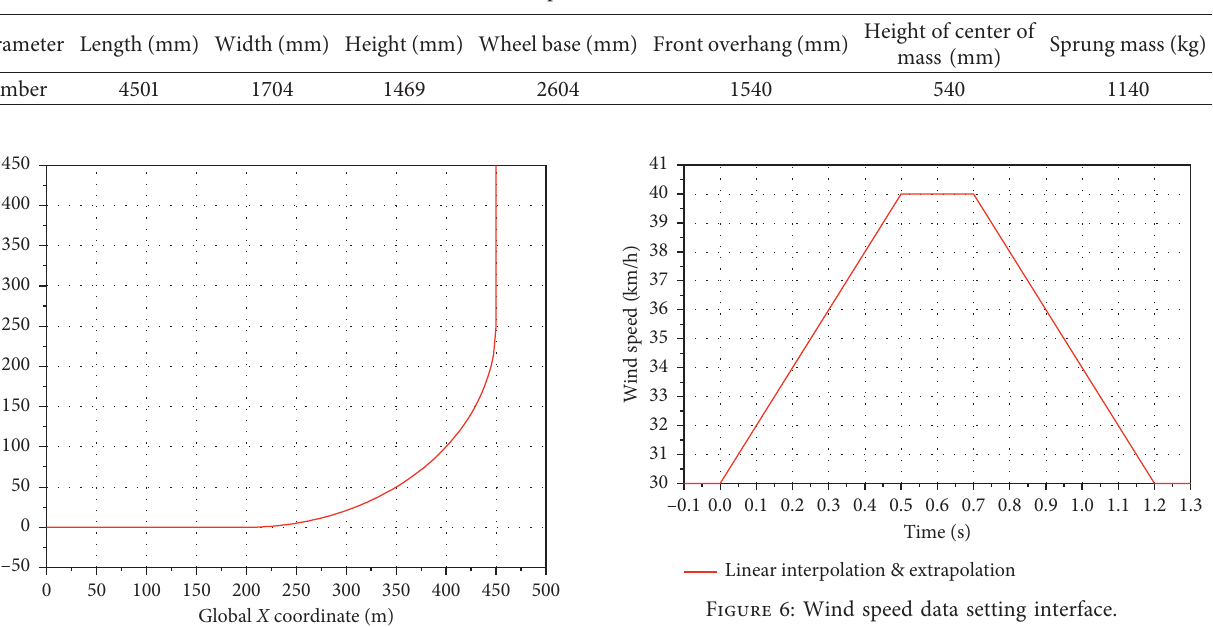
Table 6: The main parameters of model vehicle.